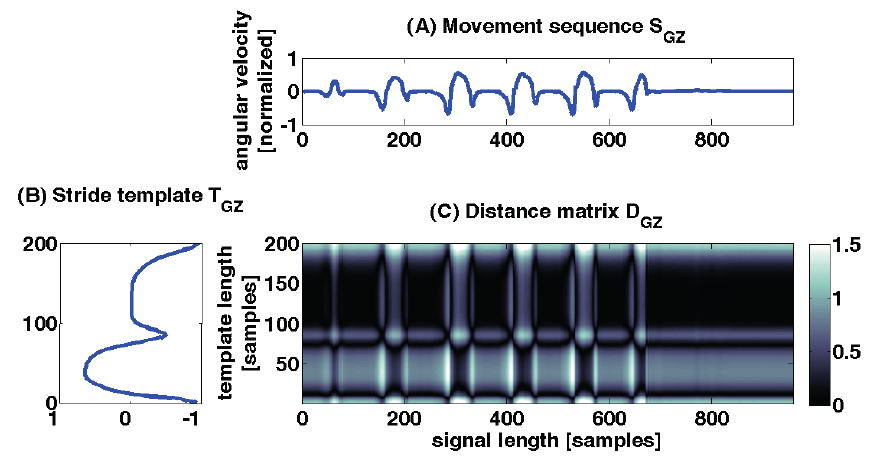
Figure 5. Distance matrix D GZ is shown as an example for one sensor axis which is calculated from S GZ and T GZ . Distance matrix was calculated from gyroscope angular velocity in sagittal plane (GZ). Deep black values in the distance matrix D GZ show less distance and higher similarity between S GZ and T GZ . White values signalize a high distance and consequently high costs. ( A ) movement sequence (cid:1845) ; ( B ) stride template (cid:1846) ; (cid:3008)(cid:3027) (cid:3008)(cid:3027) ; ( C ) distance matrix (cid:1830) (cid:3008)(cid:3027) A distance matrix (cid:1830) was constructed for each sensor axis of the accelerometer and the gyroscope and the distance matrices of all different single sensor axis were summed up to generate a new distance matrix. As an example, the combination of the sensor axes AY and GZ is given